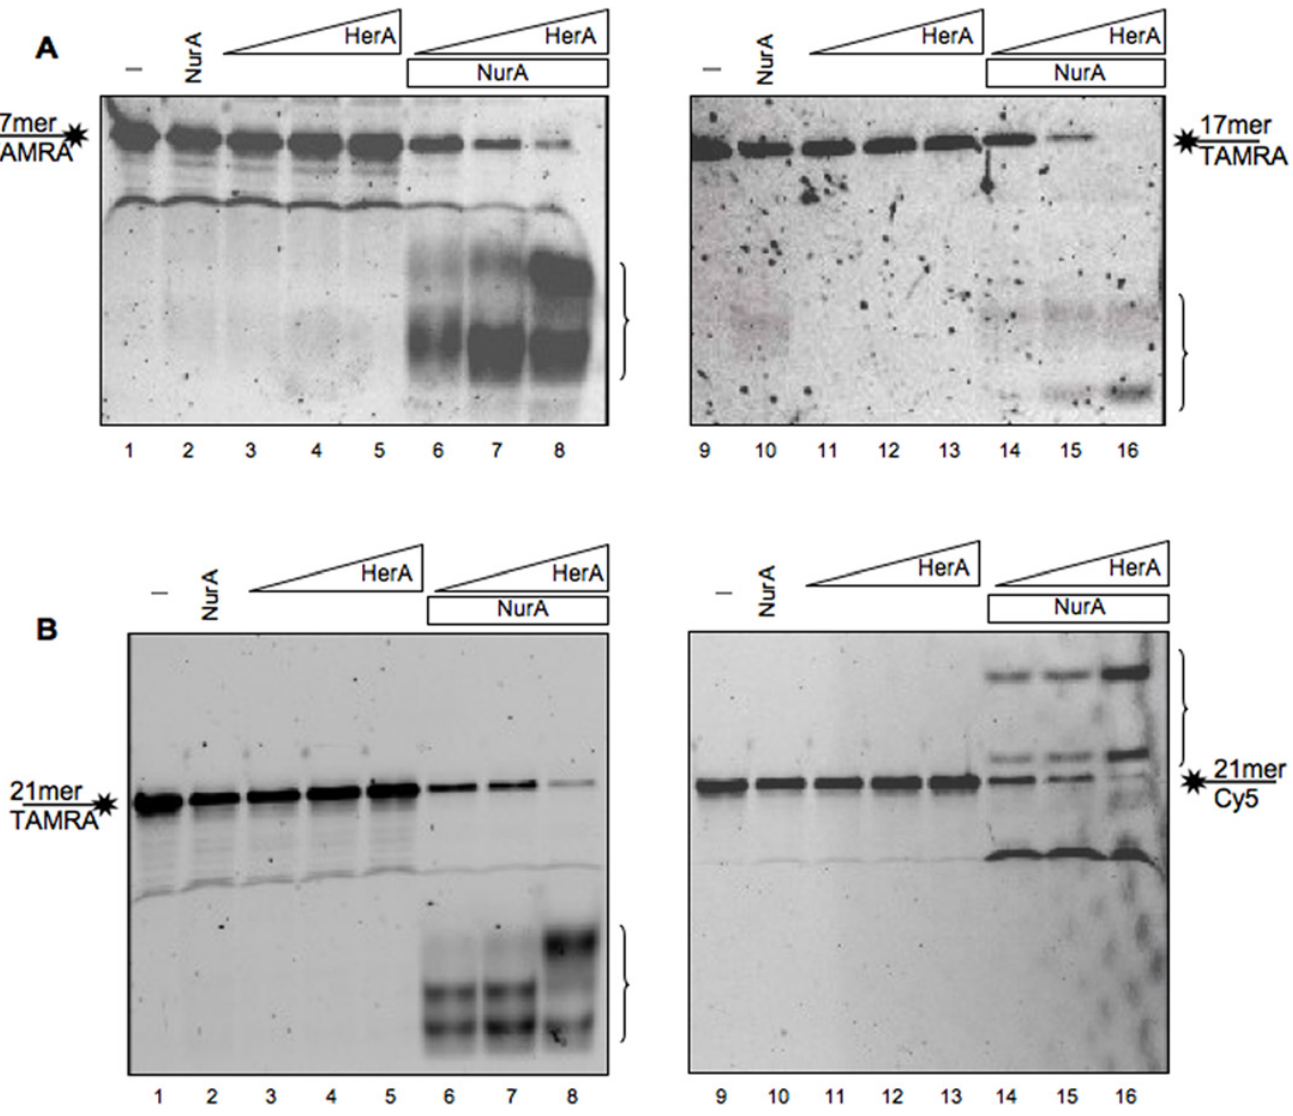
Fig 8. NurA/HerA complex activity on shorter linear single-stranded DNA molecules. (A) 7.5 pmoles of NurA (lanes 2 and 10) or increasing amounts of HerA, from 5 to 12 pmoles (lanes 3 – 5 and 11 – 13) have been analyzed separately for their nuclease activity using a linear 17 mer labeled with TAMRA at its 3 ’ - (left) or 5 ’ - (right) ends. The two proteins were then mixed together to analyze the complex activity on these substrates (lanes 6 – 8 and 14 – 16). (B) The same experiment was performed using a 21mer single-stranded oligonucleotide labeled at its 3 ’ -end with TAMRA (left) or with Cy5 at its 5 ’ -end (right). 7.5 pmoles of NurA alone (lanes 2 and 10) or increasing amounts of HerA, from 5 to 12 pmoles (lanes 3 – 5 and 11 – 13) were analyzed separately. Successively the two proteins were mixed together (lanes 6 – 8 and 14 – 16) to analyze the complex nuclease activity. Lanes 1 and 9 are controls in which the only substrate has been run to observe its